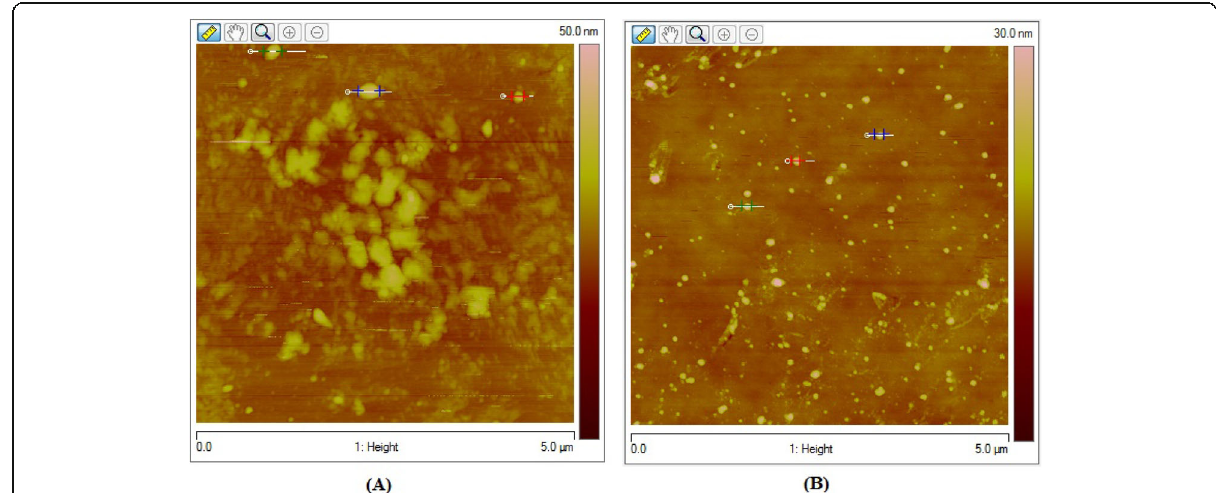
Fig. 6 AFM images of a Topotecan liposome and b placebo liposome